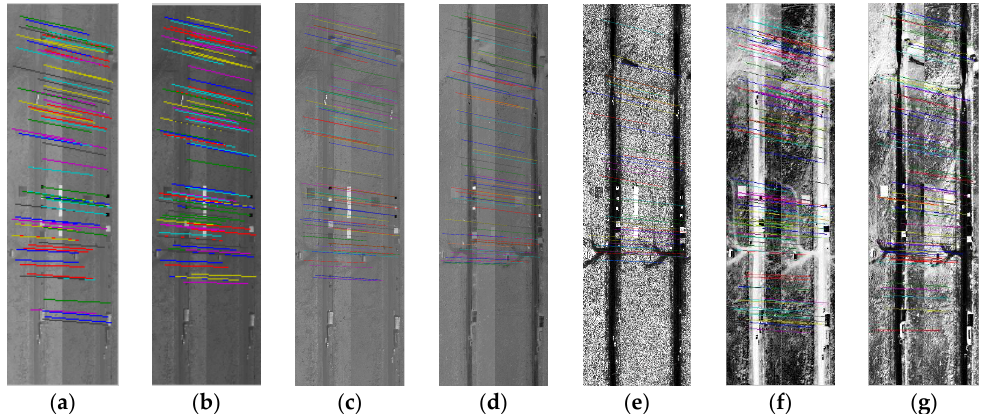
Figure 5. Resulting matched points after different 3D–2D conversions for the pair , LWIR1 a – LWIR1 b . ( a ) Brightness temperature; ( b ) average energy of radiance spectrum; ( c ) 1st PCA component of radiance spectra; ( d ) 2nd PCA component of radiance spectra; ( e ) average energy of emissivity component for each pixel; ( f ) 1st PCA component of emissivity spectra; ( g ) 2nd PCA component of emissivity spectra. Table 4. Ratio and percentage of inliers after RANSAC for different 2D maps for the images captured on the same (S) and different (D) days. “ X ” indicates the cases where there is not a sufficient number of matches to estimate the geometric transform between the images. ( BT : brightness temperature estimate, E R : average energy of radiance spectrum, PCA1 R : 1st